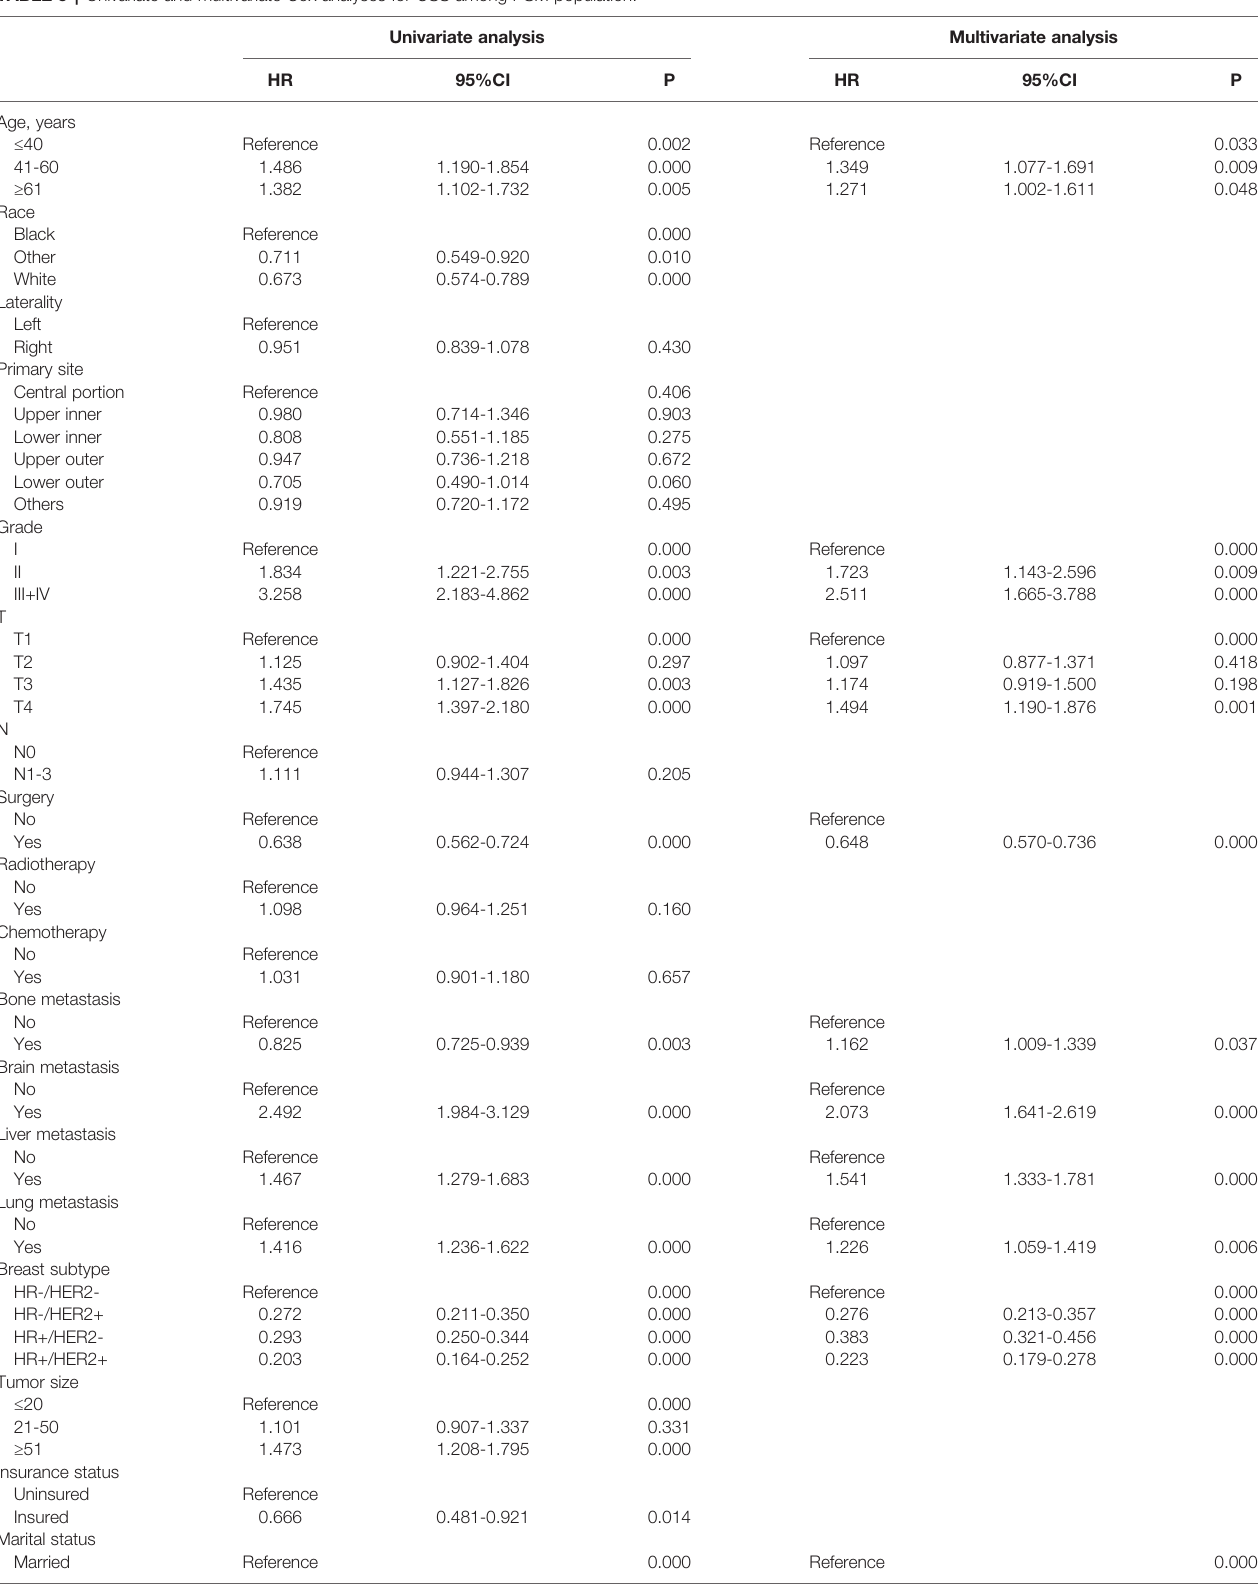
TABLE 5 | Univariate and multivariate Cox analyses for CSS among PSM population. Univariate analysis Multivariate